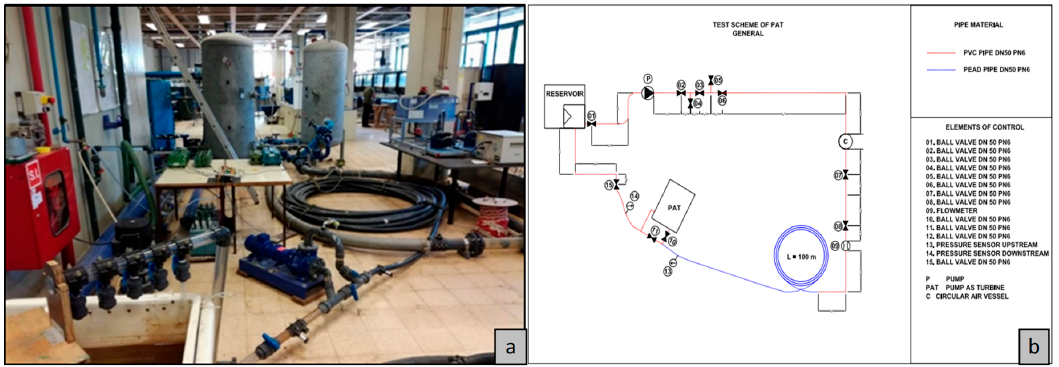
a b Figure 6. Lab set-up. ( a ) experimental facility at IST; ( b ) scheme of the facility [6].